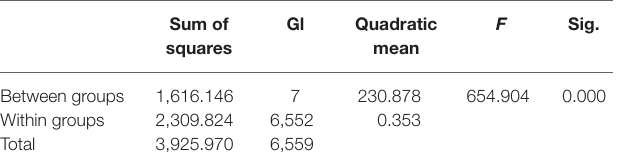
TABLE 9 | ANOVA test between cognitive level and historical concepts.